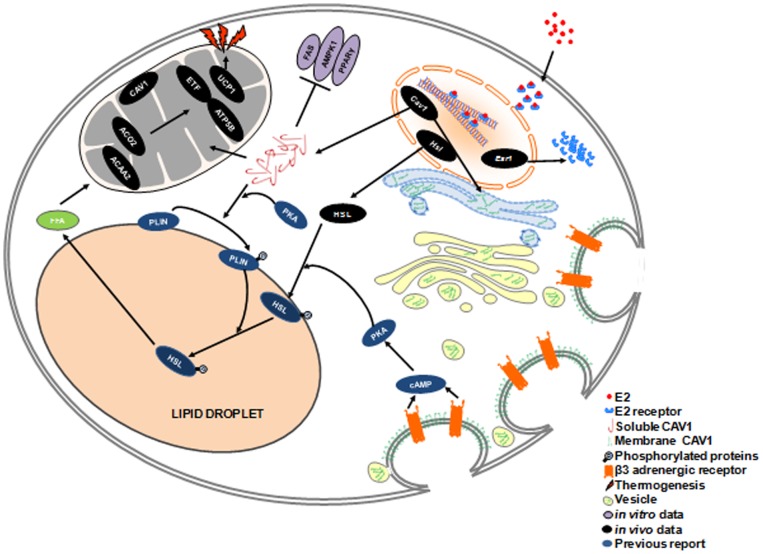
Possible roles of CAV1 in E2-dependent regulation of adipocyte metabolism.